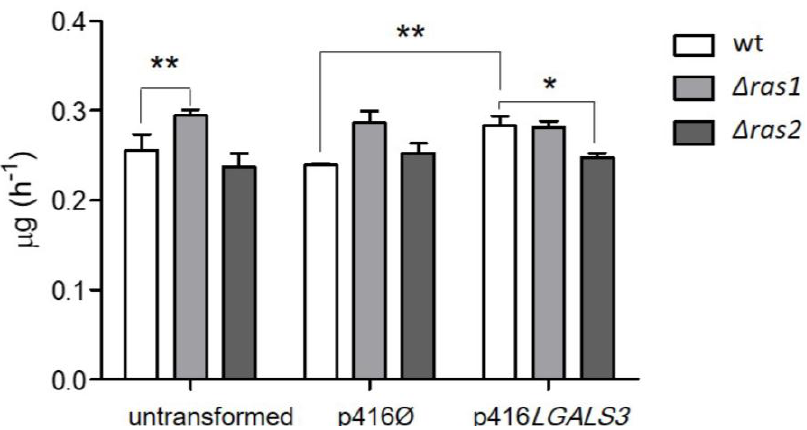
Figure 12. S. cerevisiae wt, Δras1 and Δras2 transformed with p416 LGALS3 were grown on glucose for 28 h from O.D. 600 0.05 up to stationary phase. The untransformed yeasts and the yeasts transformed with the empty plasmid (p416 Ø) were used as controls. Specific growth rates were estimated from log phase. Graphs show the average specific growth rate ± SD of three independent experiments. Statistical significant differences are shown: * ( p -value ≤ 0.05) and ** ( p -value ≤ 0.01).